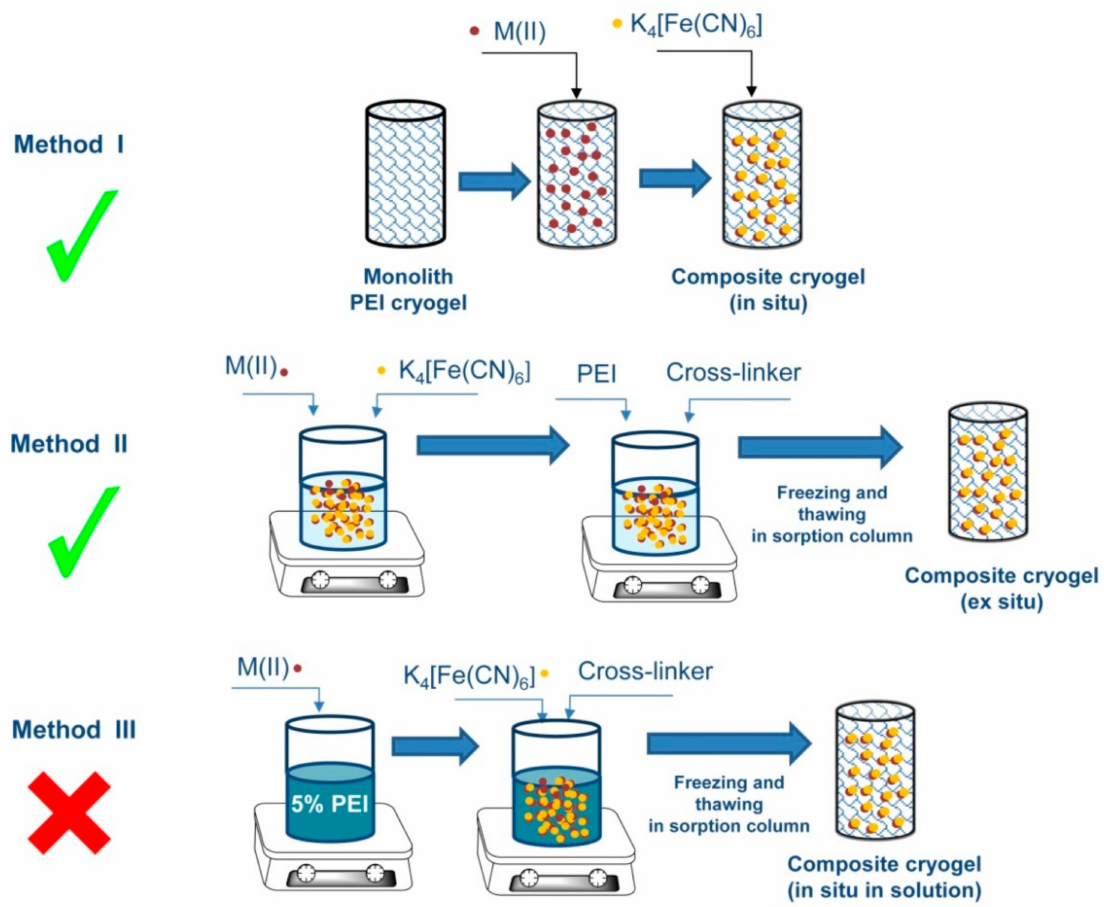
Figure 1. Schemes of the composite cryogel